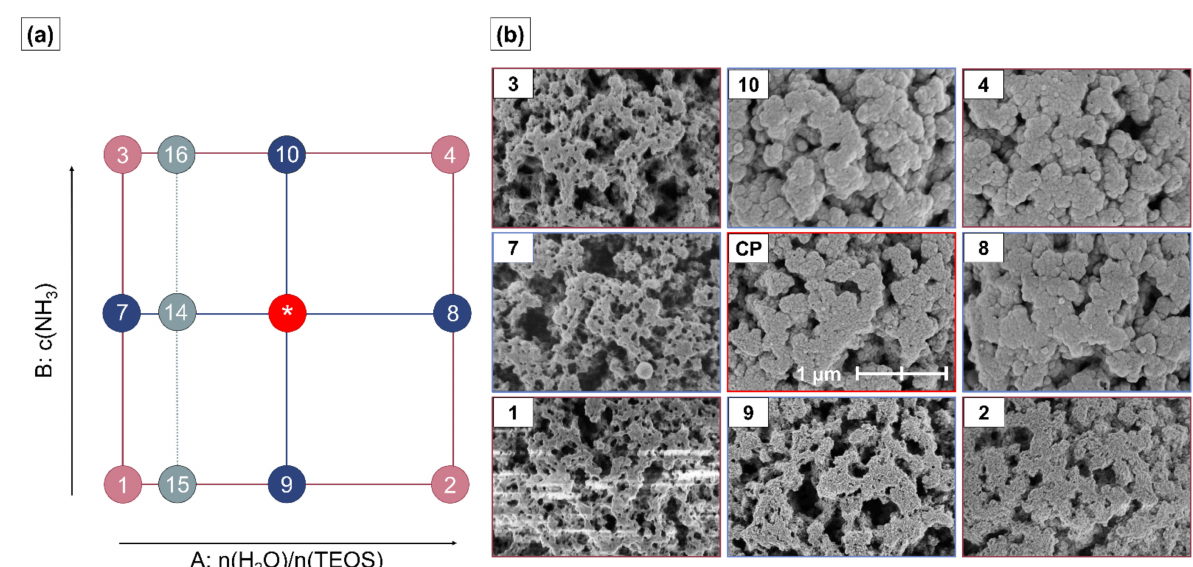
Figure 4. ( a ) Schematic representation of the design space covered by the factor-level combinations used in the face-centered-central composite design including the additional design points HB14–16. ( b ) Systematic overview over SEM images at 50,000 × magnification of each sample obtained at the various factor-level combinations. A representative example of the center point (CP) combinations, HB13, is shown. Factorial design points (HB1–4) are displayed in dark red, center points are displayed in red (HB5–6, HB11–13), axial design points (HB7–10) are displayed in blue, and additional design points are shown in grey (HB14–16). Numbers reflect the Yates standard order. SEM images of the additional design points HB14–16 are shown separately in Appendix B Figure A2. * indicates the center point experiments at intermediate factor level